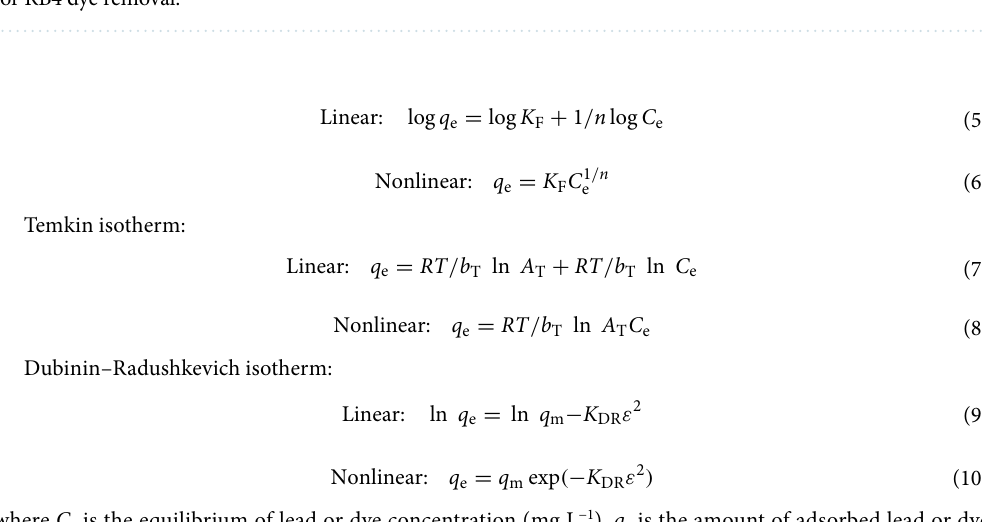
Figure 10. The desorption experiments of ( a ) sawdust powder (SP), sawdust powder doped iron (III) oxide- hydroxide (SPF), sawdust beads (SPB), and sawdust powder doped iron (III) oxide-hydroxide beads (SPFB) for lead removal and ( b ) sawdust beads (SPB) and sawdust powder doped iron (III) oxide-hydroxide beads (SPFB) for RB4 dye